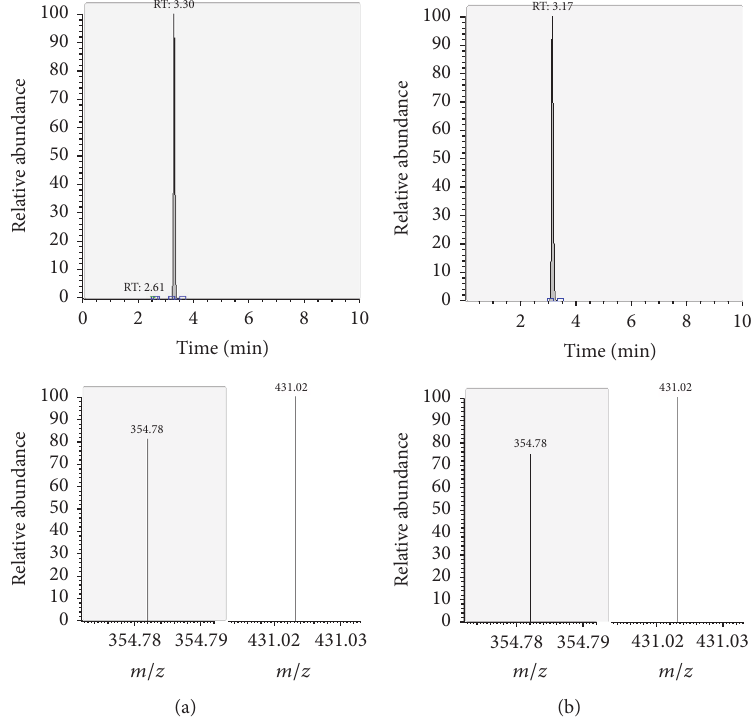
Figure 11: LC-MS/MS chromatograms of FLA and SRM transitions and relative abundances. (a) Standard in a 100 𝜇 gL −1 solution. (b) Standard in the spiked sample at 100mg kg −1